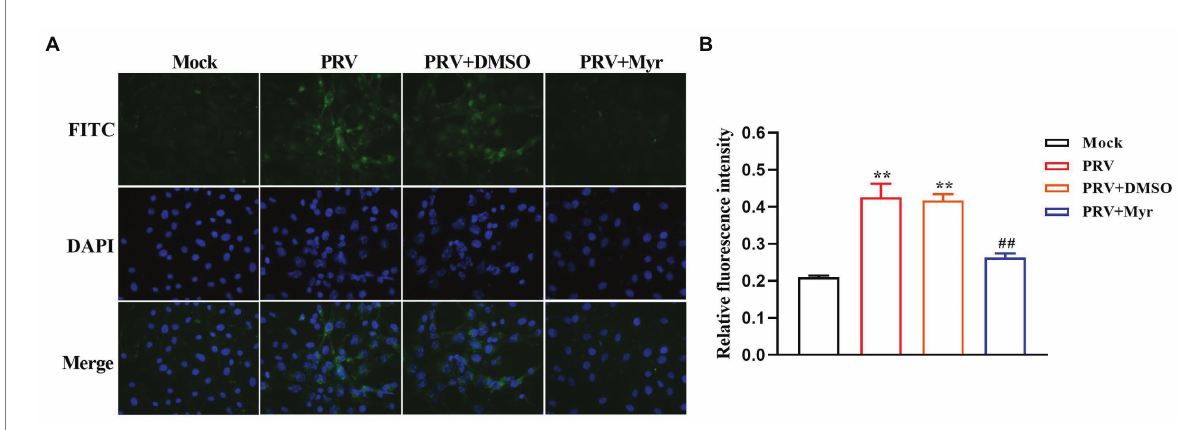
FIGURE 2 Indirect immunofluorescence. (A) PK-15 cells were infected with PRV (MOI = 0.1) in the presence of myricetin, and subjected to immunostaining at 24 h post-infection. Green, PRV virion; blue, nuclei. Magnification, 400X. (B) Relative fluoruminosity was counted by using the ImageJ software. The value is defined as the ratio of green fluorescence to blue fluorescence. Mock, the uninfected-untreated group; PRV, the infected group without treatment; PRV + DMSO, the infected group with DMSO treatment (0.5%); PRV + Myr, the infected group with myricetin treatment. Data are presented as mean ± SD, n = 6. Symbol “**” represents p < 0.01 between the mock group and other groups. Symbol “##” represents p < 0.01 between the PRV group and PRV + Myr group.